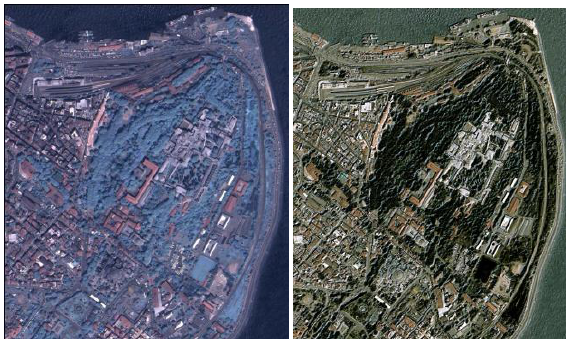
Figure 14: left: standard Brovey pan-sharpening; right: modified Brovey pan-sharpening